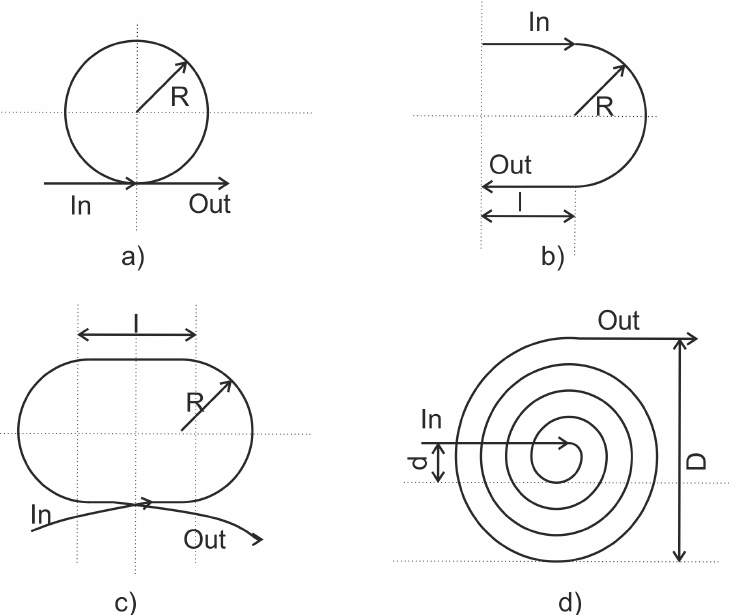
Figure 11. Different Configurations for FOD sensors ( a ) circle ( b ) U shaped ( c ) elongated circle ( d ) spiral.